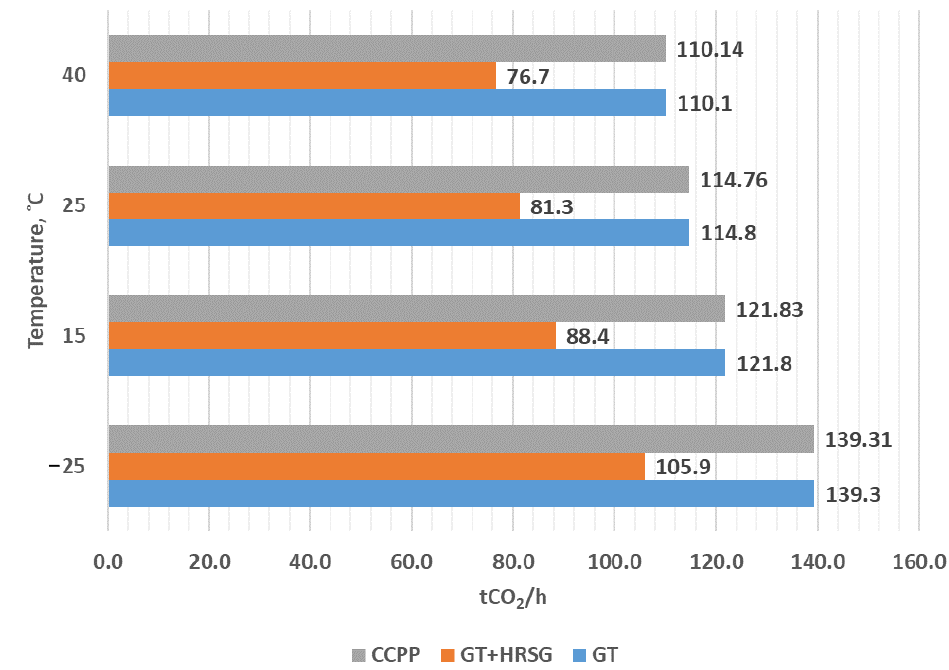
Figure 13. CO 2 emissions from the schemes under consideration.